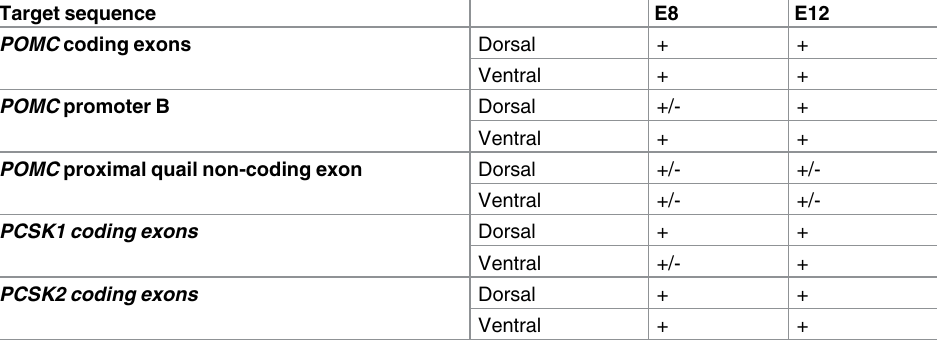
Table 2. Expression of POMC , POMC alternatively spliced exons, PC1 and PC2 in quail at embryonic stage E8 and E12 determined by RT-PCR. Target sequence E8 E12 POMC coding exons Dorsal + + + POMC promoter B Dorsal +/- + Ventral + + POMC proximal quail non-coding exon Dorsal +/- +/- Ventral +/- +/- PCSK1 coding exons Dorsal + + Ventral +/- + PCSK2 coding exons Dorsal + + Ventral + + “+” = present, and “+/-” = variable